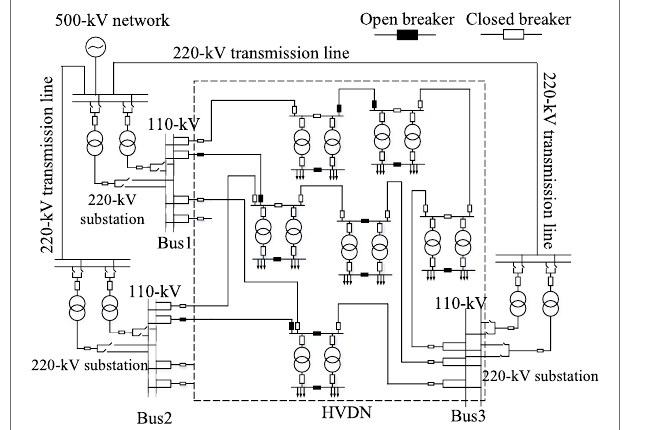
FIGURE 1 | Illustration of the urban power grid structure.